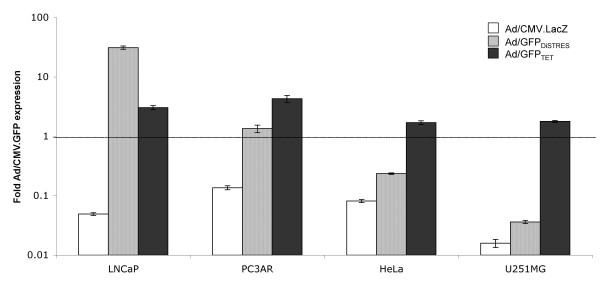
Comparison of DiSTRES- and CMV-mediated gene expression. LNCaP, PC3AR, HeLa and U251MG cells were seeded at 1.25 × 104 cells/well in 96-well plates and infected with complex Ad vectors at MOI 30, 200, 200, and 50, respectively, in the presence 30 nM DHT. 2 days post-infection, cell lysates were assayed for GFP fluorescence. Infection with Ad/C.LacZ served as a negative control infection. Results are displayed as fold expression, setting GFP fluorescence from Ad/CMV.GFP infection at 1 for each cell line. Due to differing transduction efficiencies among cell lines, each cell type was infected at an optimized MOI, based on pilot dose response studies conducted with the Ad/GFPTET vector. MOI values were based on IU/ml. *p < 0.05 compared to Ad/CMV.GFP. †p < 0.05 compared to Ad/GFPTET.